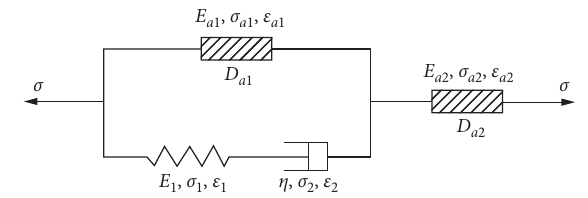
Figure 10: The mechanical model of rock unit